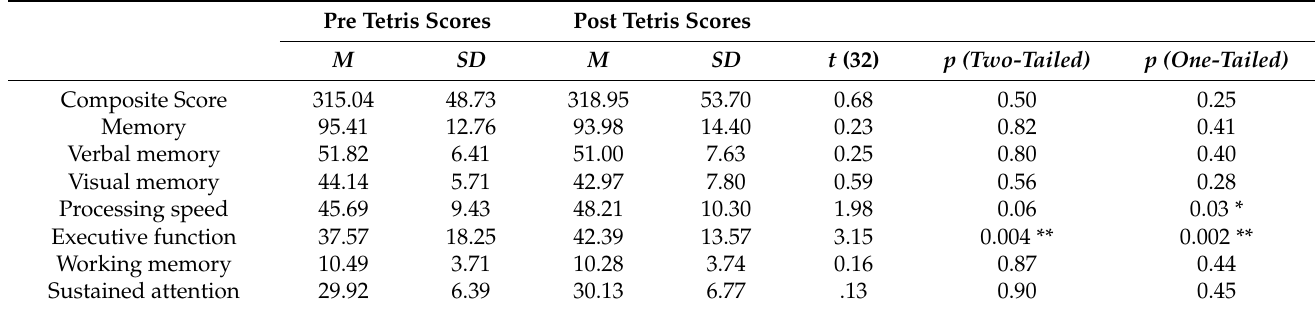
Table 3. Pre- and post-cognitive assessment results for the Tetris (ACT) group. Pre Tetris Scores